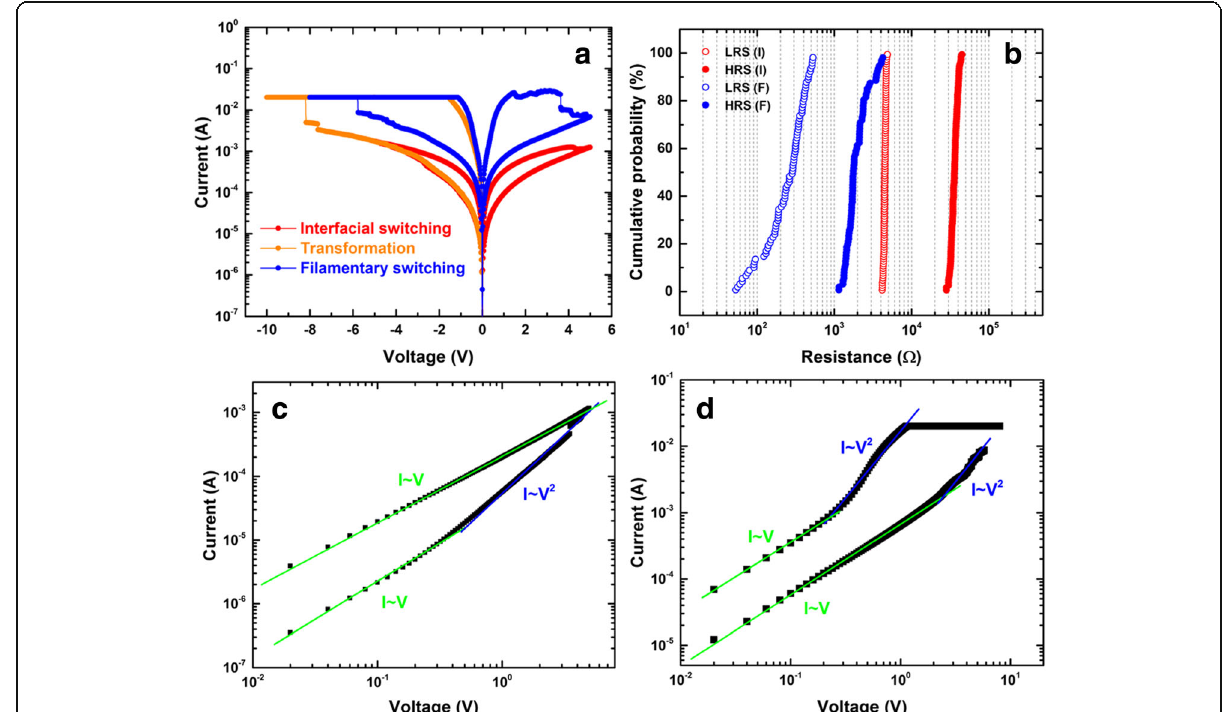
Fig. 5 a I – V characteristics of the transformation process ( orange ) from the interfacial switching ( red ) to the filamentary switching ( blue ). b Cumulative probability graph of HRS and LRS for both interfacial ( V RESET =6 V) and filamentary switching modes. The SET process I – V curves of the c interfacial and d filamentary switching modes in double-logarithmic